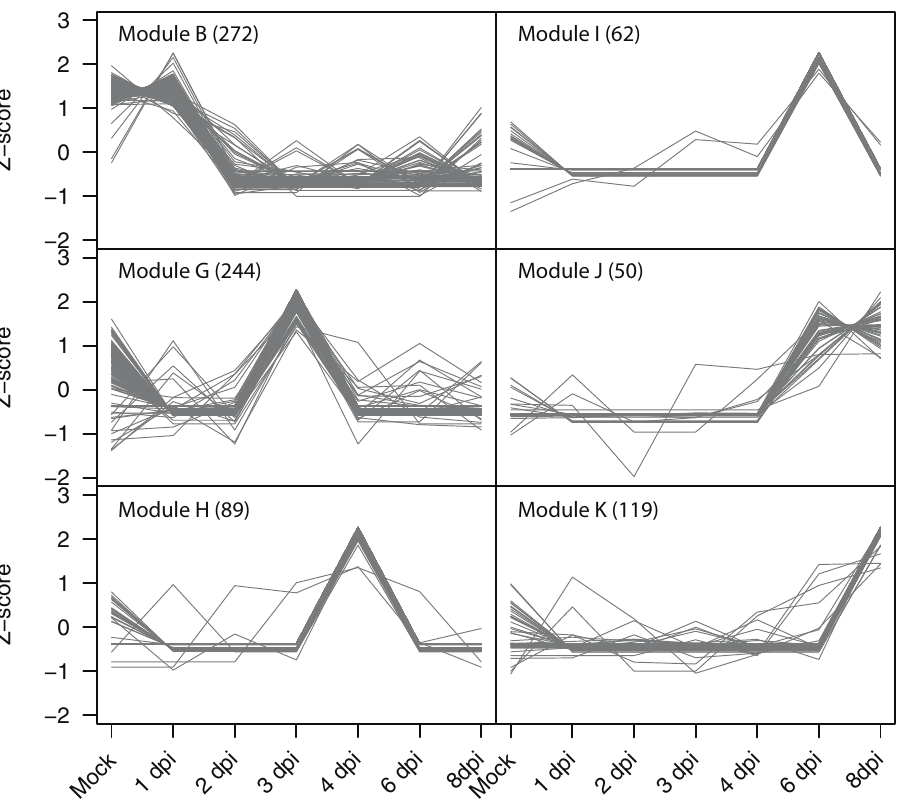
Figure 7. Trend plots of the normalized gene expression values from six identified gene co-expression modules. Modules consisting of genes down-regulated at 2 dpi (Module B), genes up-regulated at a single time point (Modules G, H, I, K), and genes up-regulated at two time- points (Module J) are shown. The number of genes in each module is shown in parentheses.